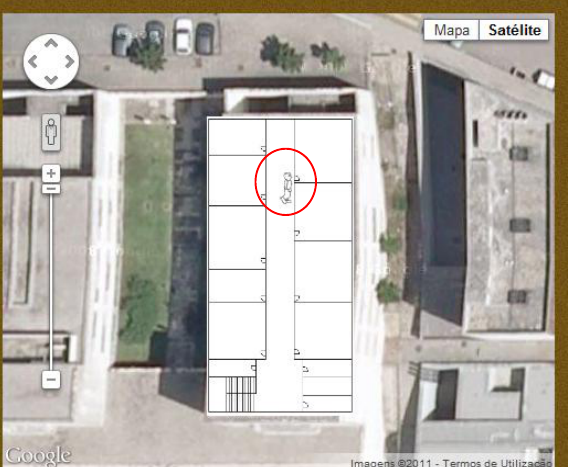
Figure 3. Current Web Interface displaying a user’s location and a simple avatar (circled